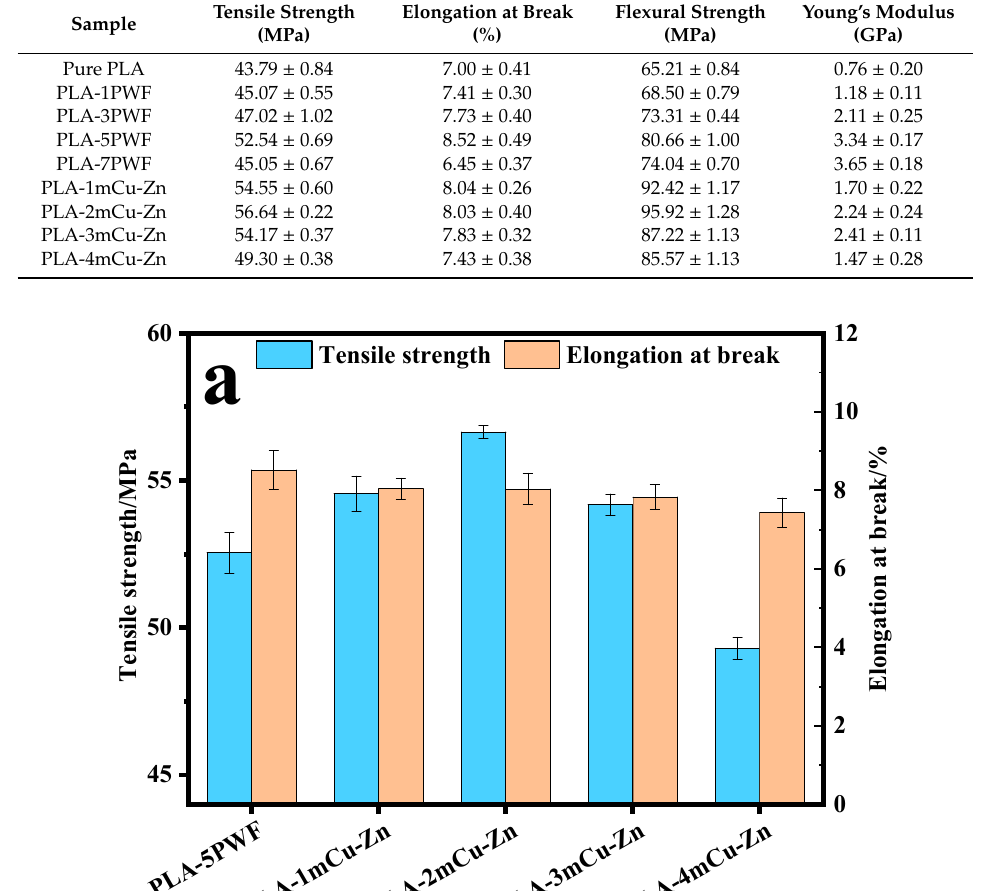
Table 2. Mechanical properties of PWF / PLA and mCu-Zn / PWF / PLA composites.